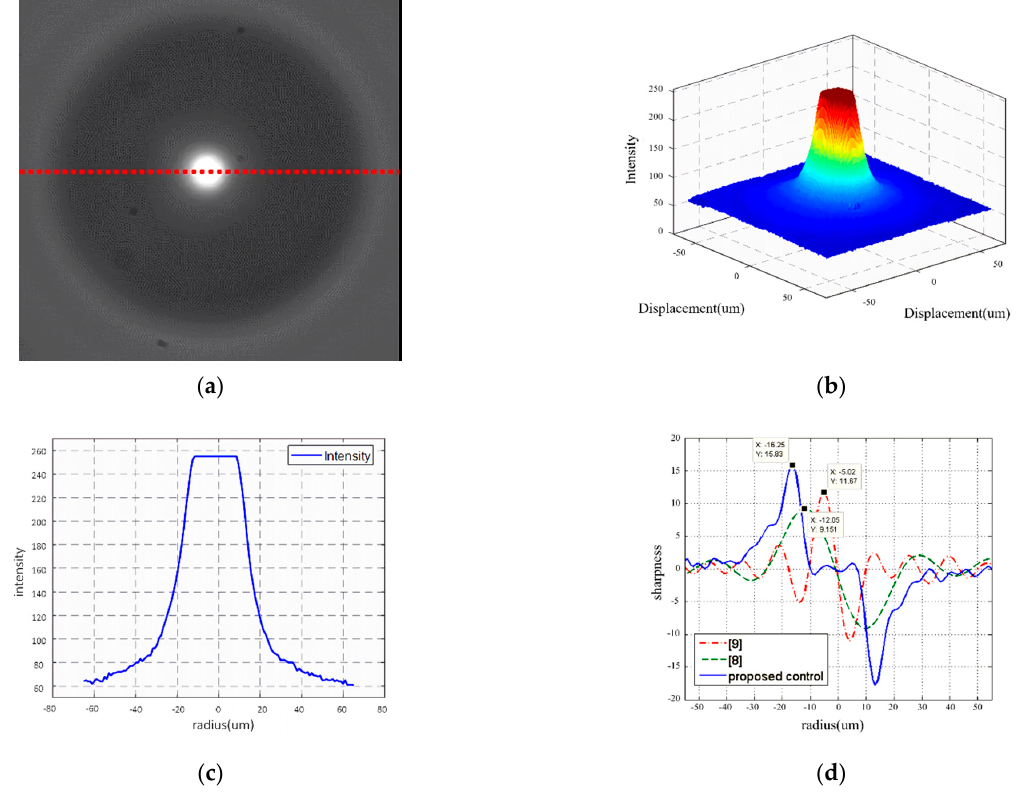
Figure 13. Optical properties of the micro-lens: ( a ) light spot; ( b ) brightness; ( c ) image intensity; ( d ) image sharpness. Table 5. Comparison of the lens